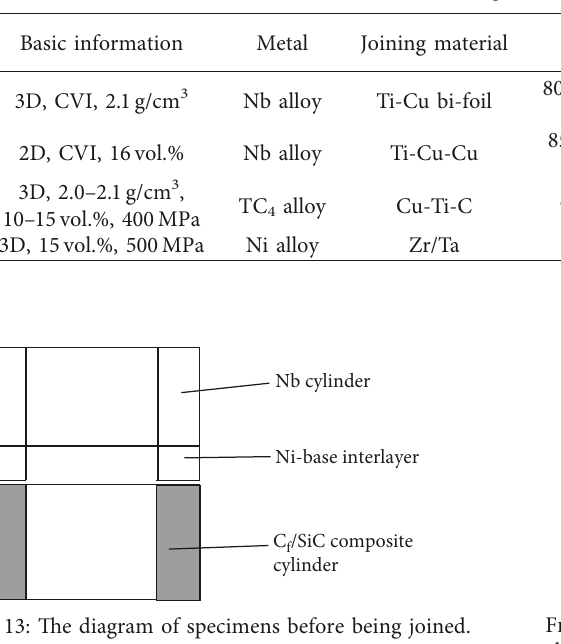
Figure 12: (a) Micrographs and (b) XRD pattern of the interface Table 8: Diffusion bonding of C f /SiC composites to metals.